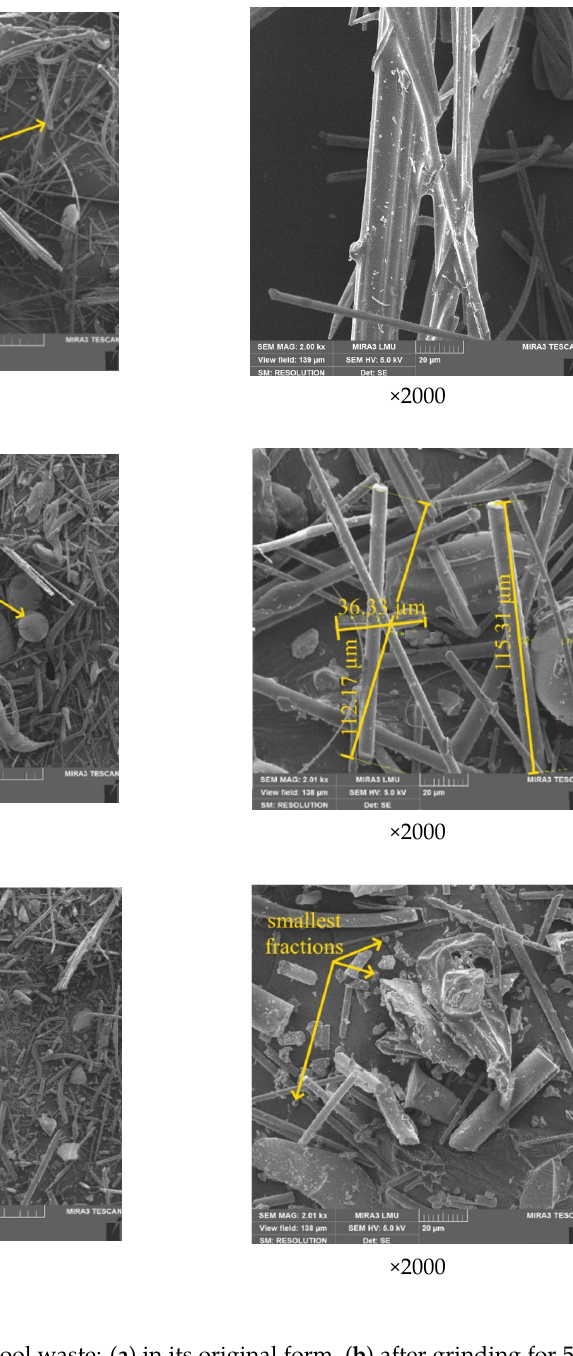
Figure 5. SEM images of mineral wool waste: ( a ) in its original form, ( b ) after grinding for 5 min, and ( c ) after grinding for 10 min.